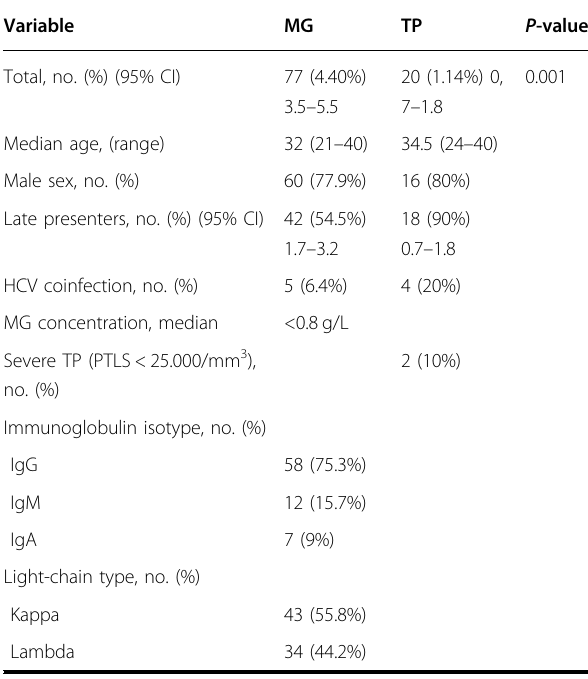
Table 1 Patients ’ characteristics a